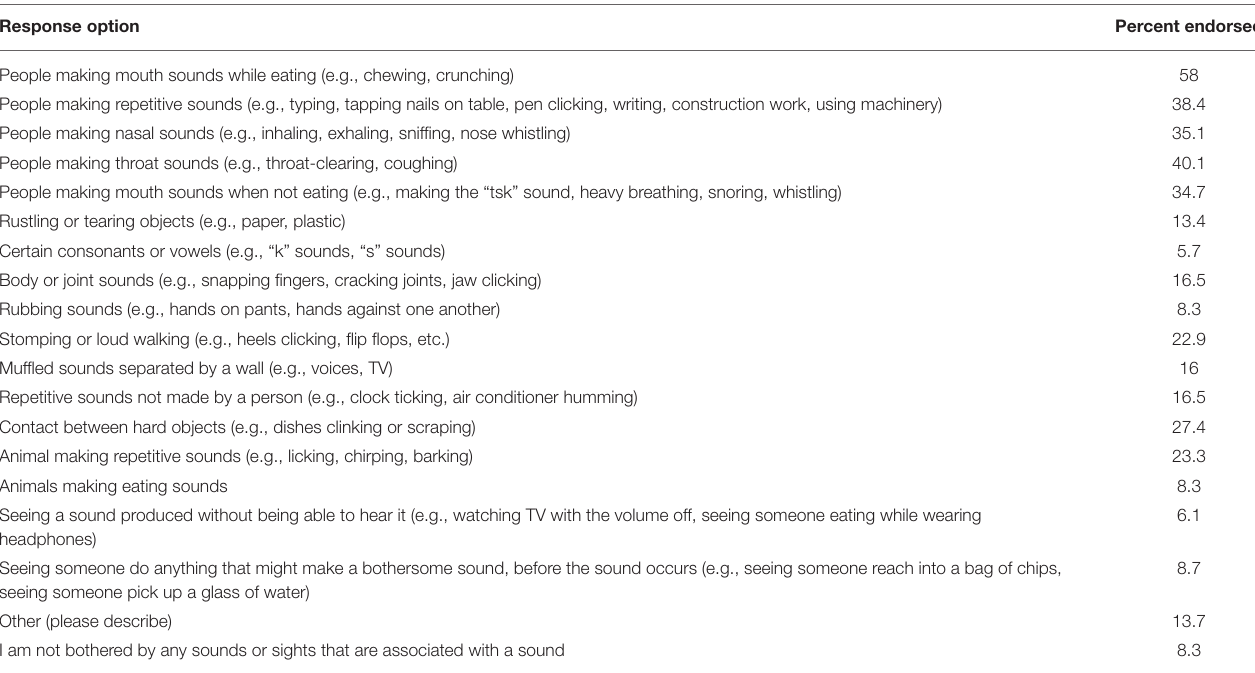
TABLE 2 | Endorsement rates for Duke Misophonia Questionnaire sound type by item. Response option